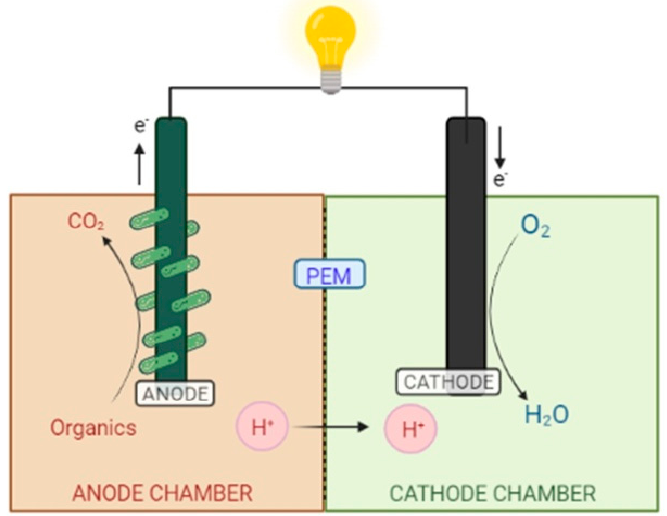
Figure 5. Microbial fuel cell (PEM = proton exchange membrane).